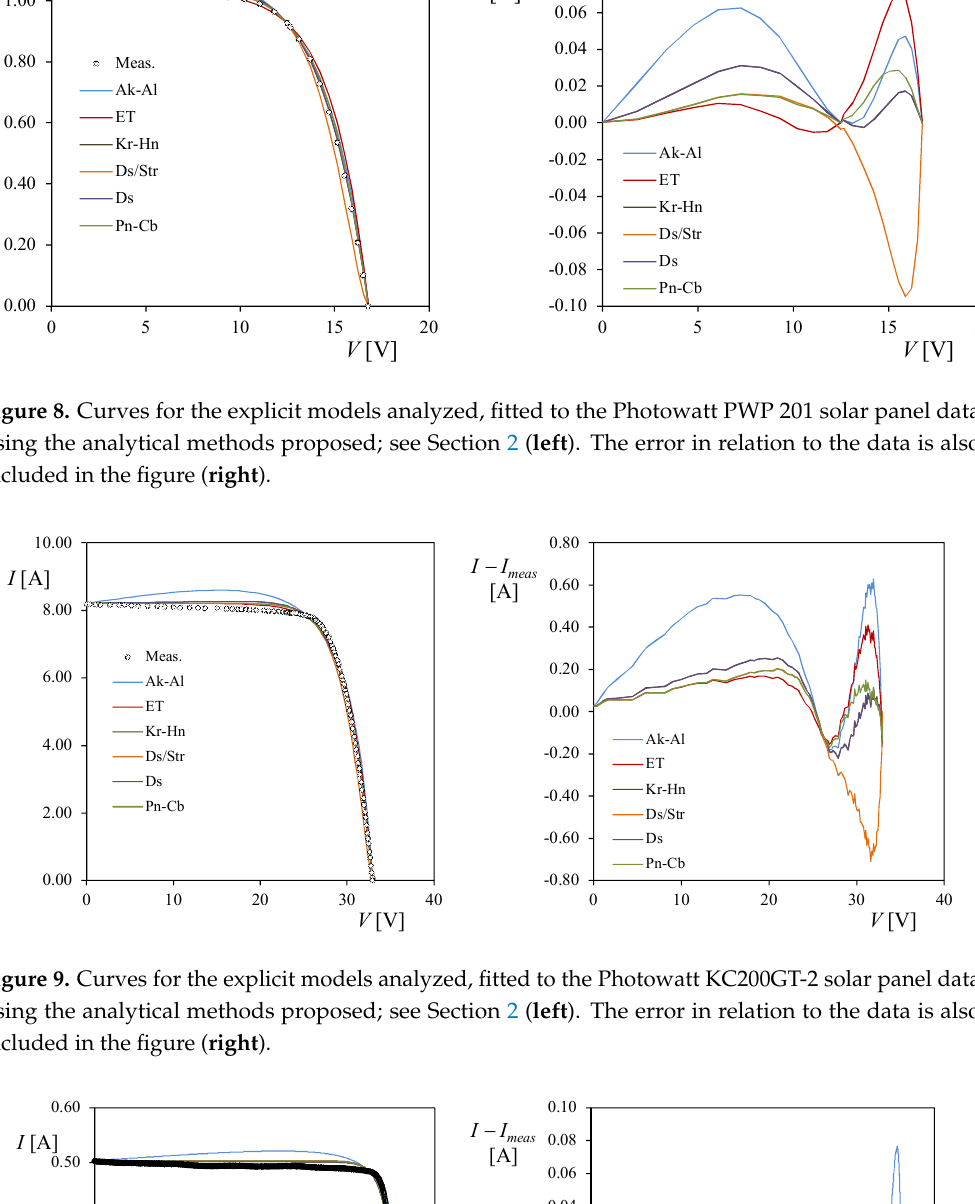
in the figure ( right ).